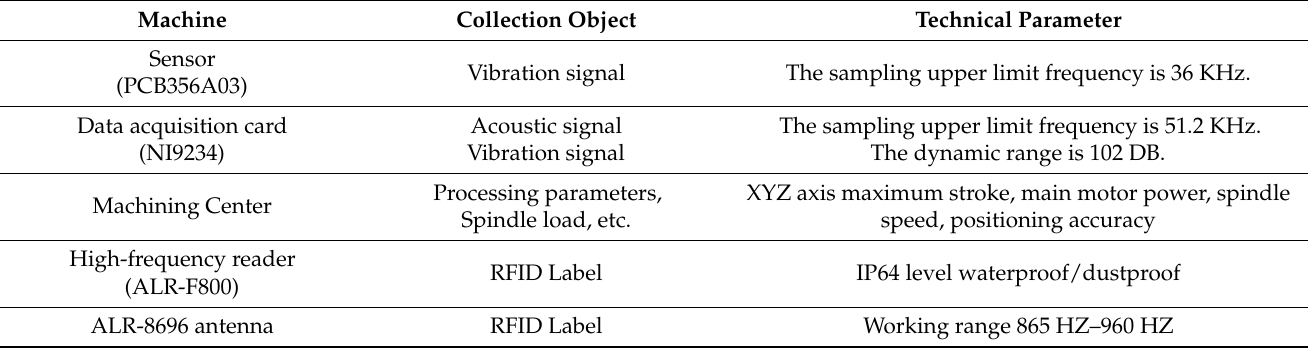
Table 5. Data collection equipment and main parameters.